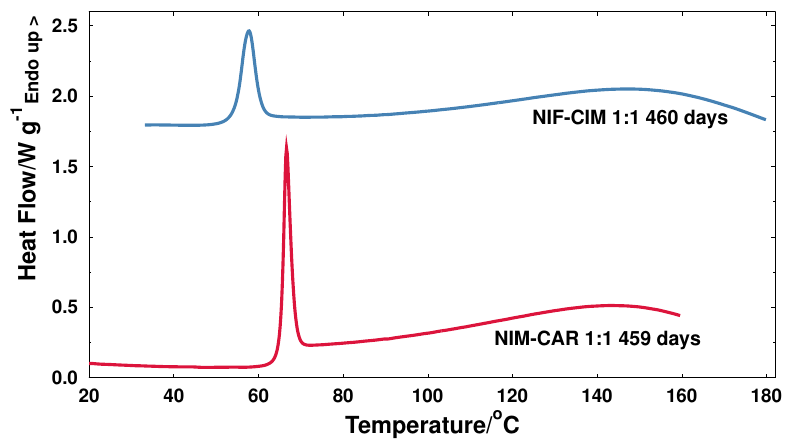
Figure 8. Long-term stability of binary mixtures after storage of more than 15 months at room temperature shown in the DSC